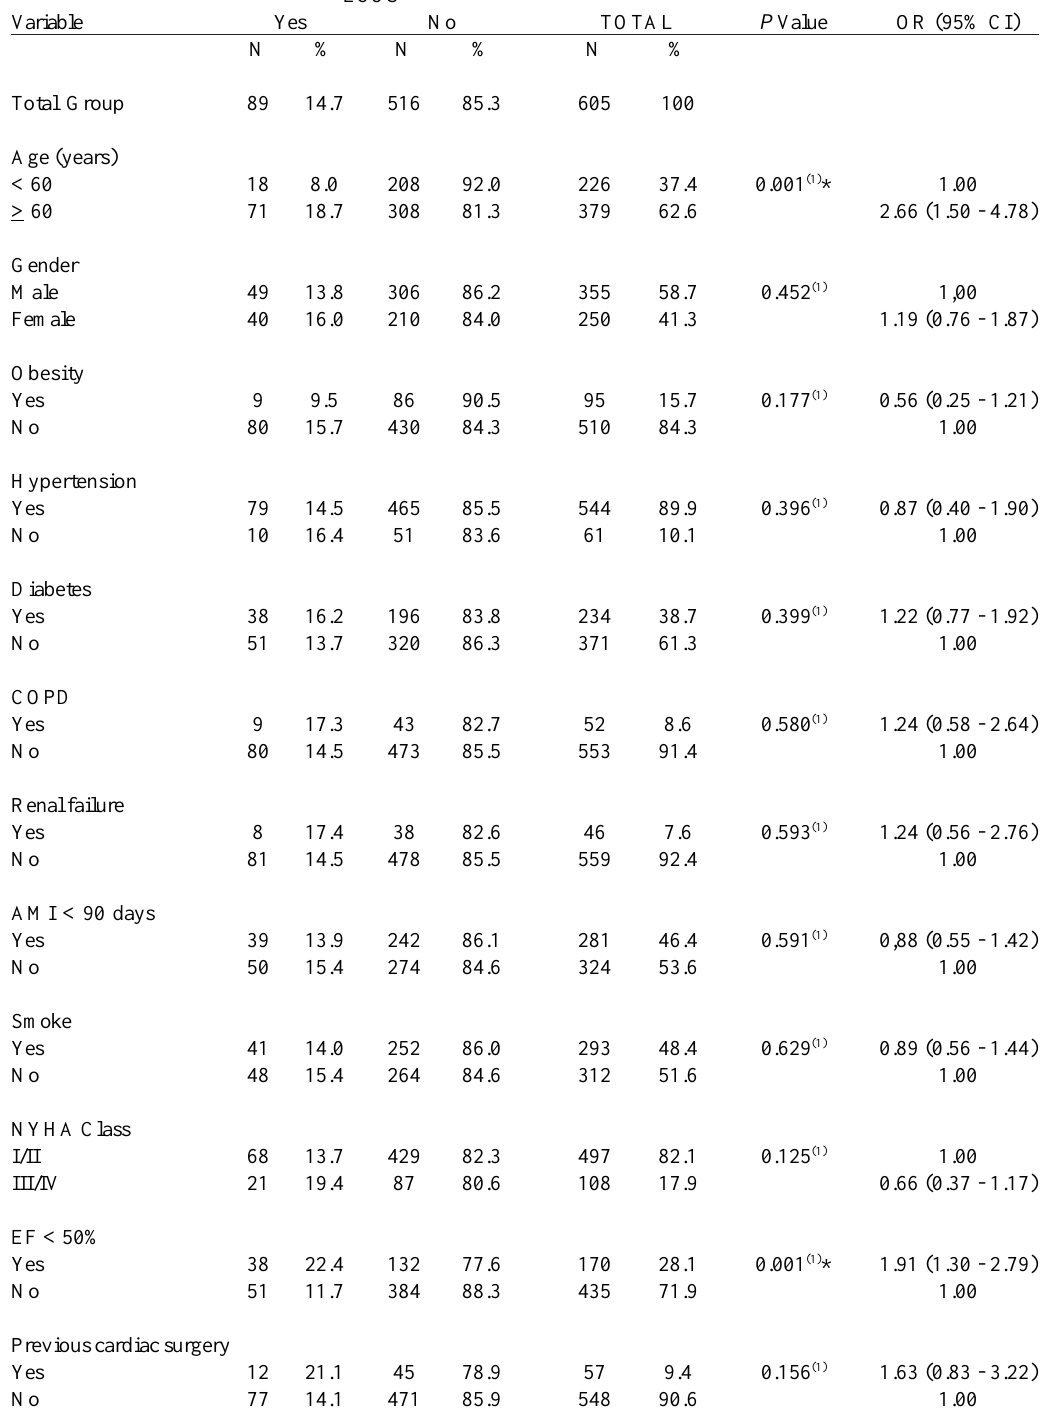
Table 1. Incidence of LCOS according to preoperative variables.